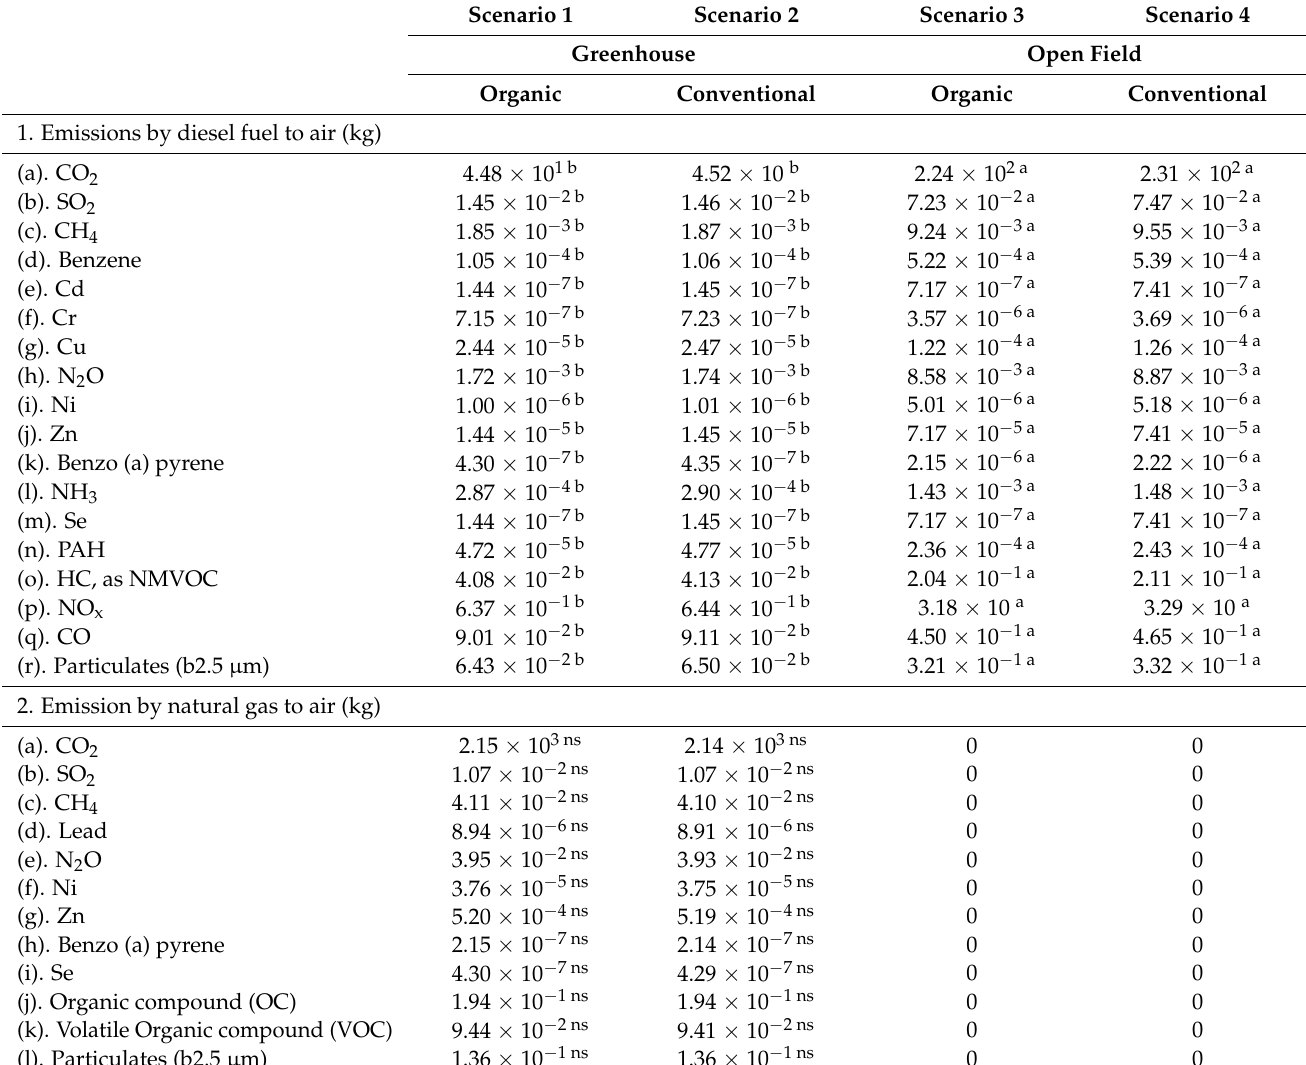
Table 5. Emissions by diesel fuel and natural gas (kg) to air in different scenarios. Different lower cases indicate significant differences. ns : Not